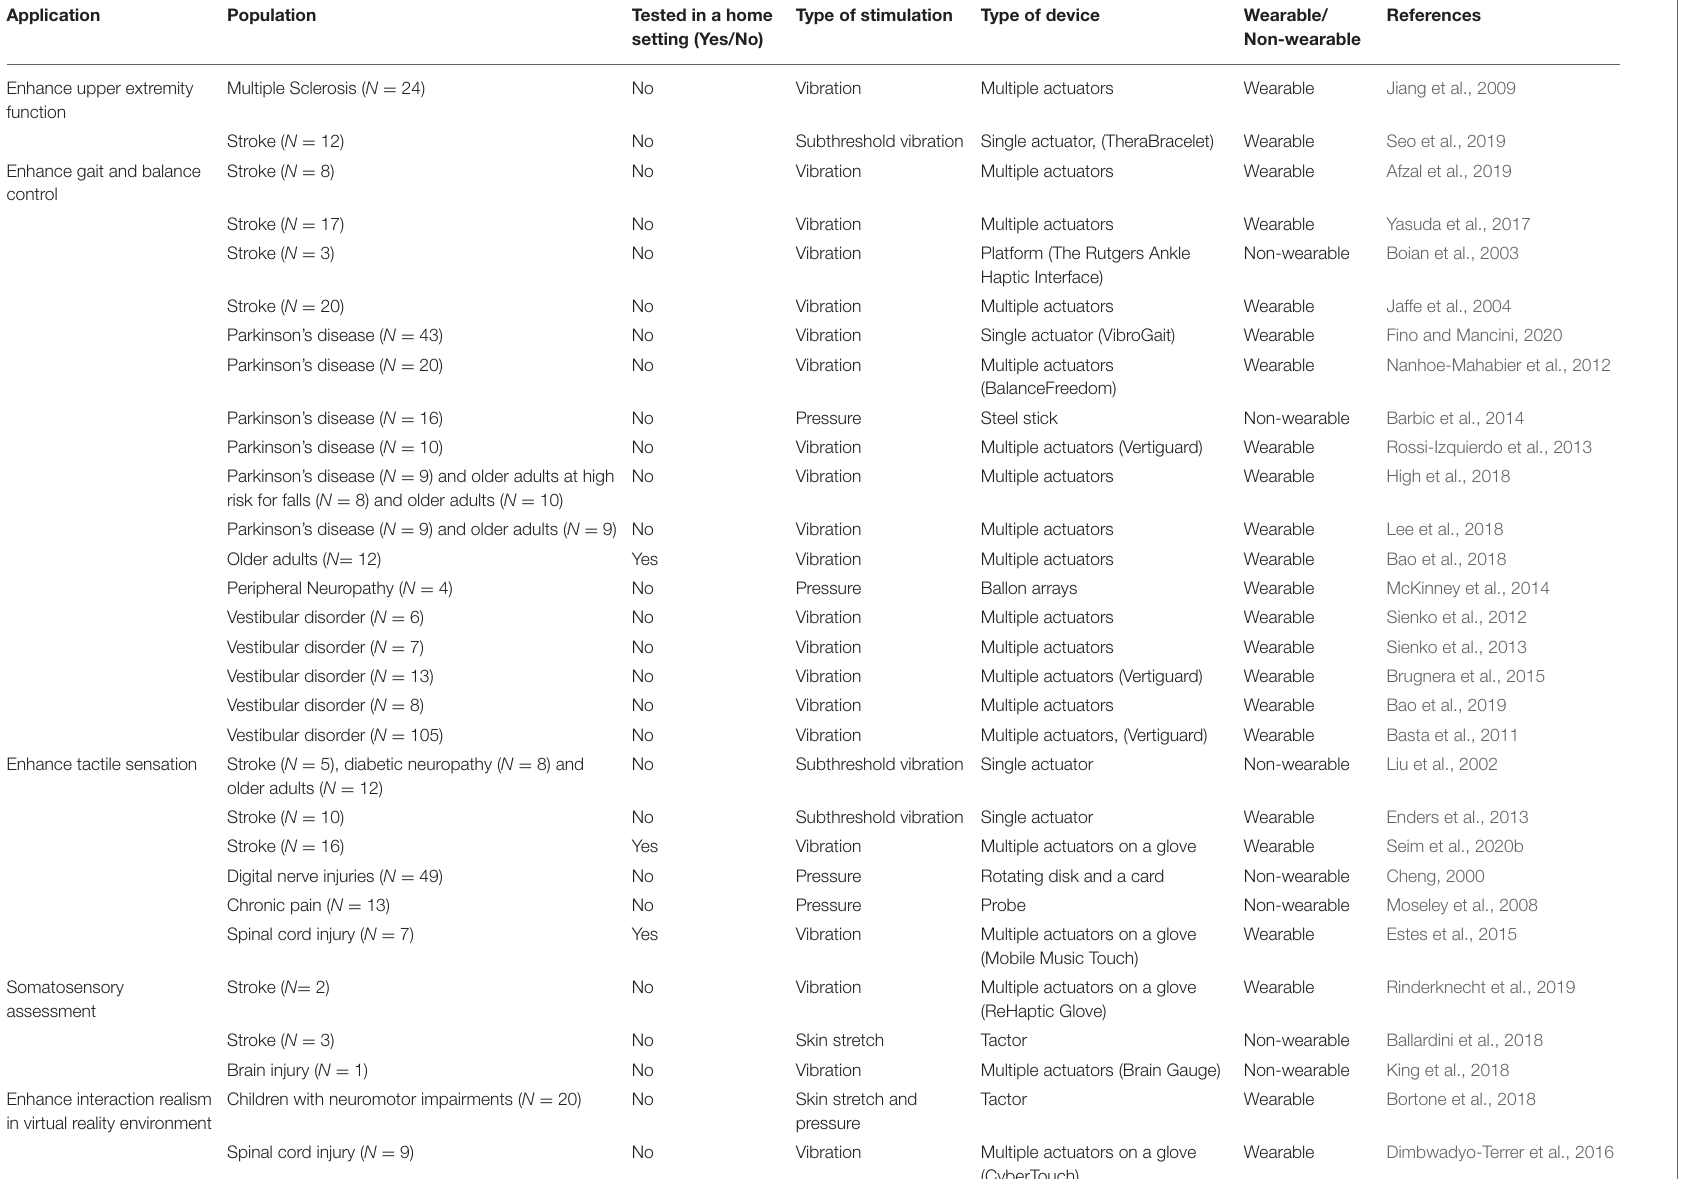
TABLE 2 | Tactile device applications for